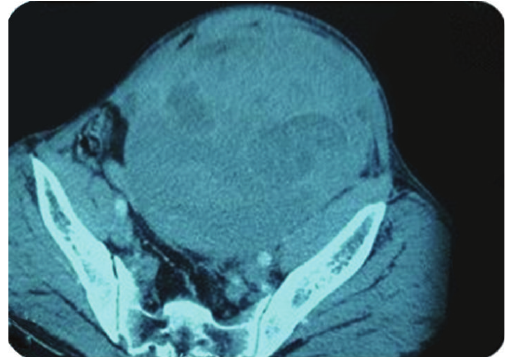
Figure 2: Showing CECT picture of a sarcoma (fat is not delineated nicely).